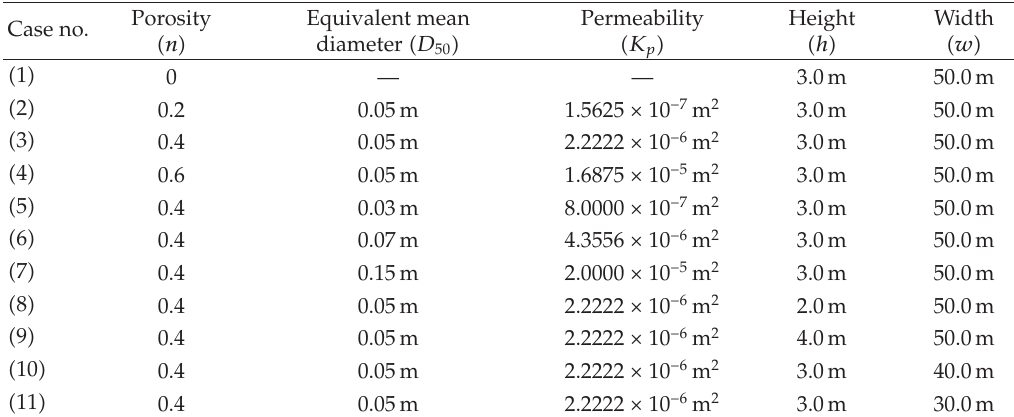
Table 1: Numerical cases with di ff erent breakwater